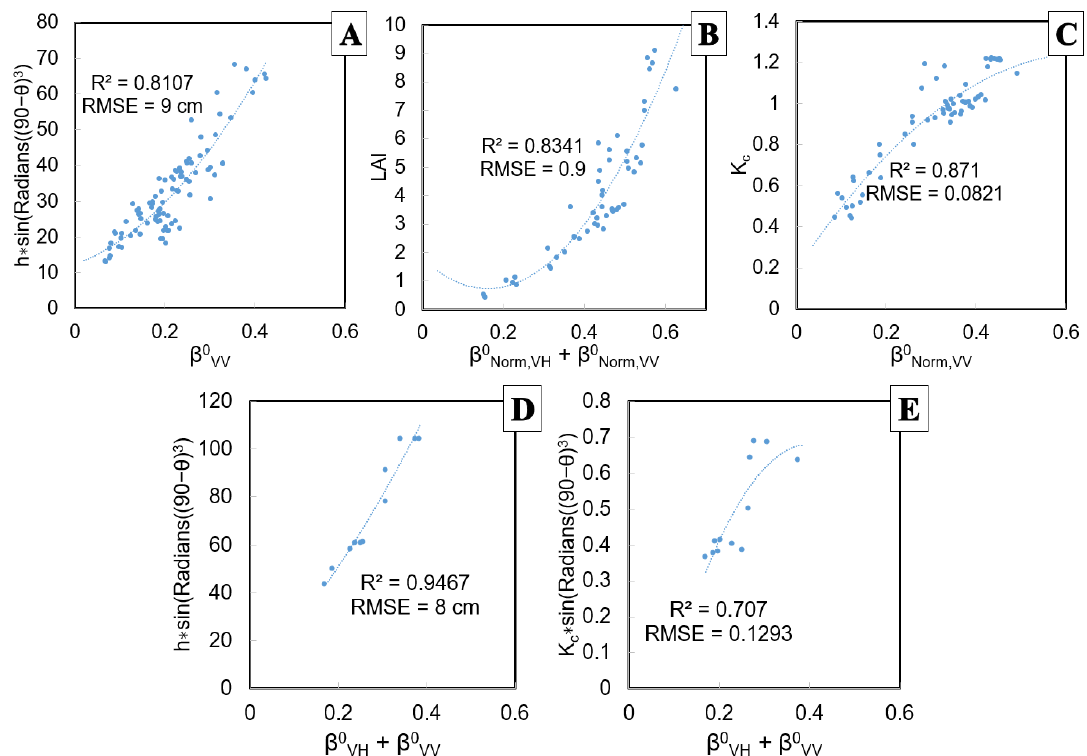
Figure 9. Models based on field measurements and the β 0 normalization method: ( A ) processing tomato height; ( B ) pro- cessing tomato LAI; ( C ) processing tomato K c ; ( D ) cotton height; ( E ) cotton K c . Table 3. R 2 and RMSE improvements following the local incidence angle normalization procedure. Significance is marked by *. The percentage values in the brackets show improvement in RMSE after normalization (i.e., the reduction in predic- tion error).